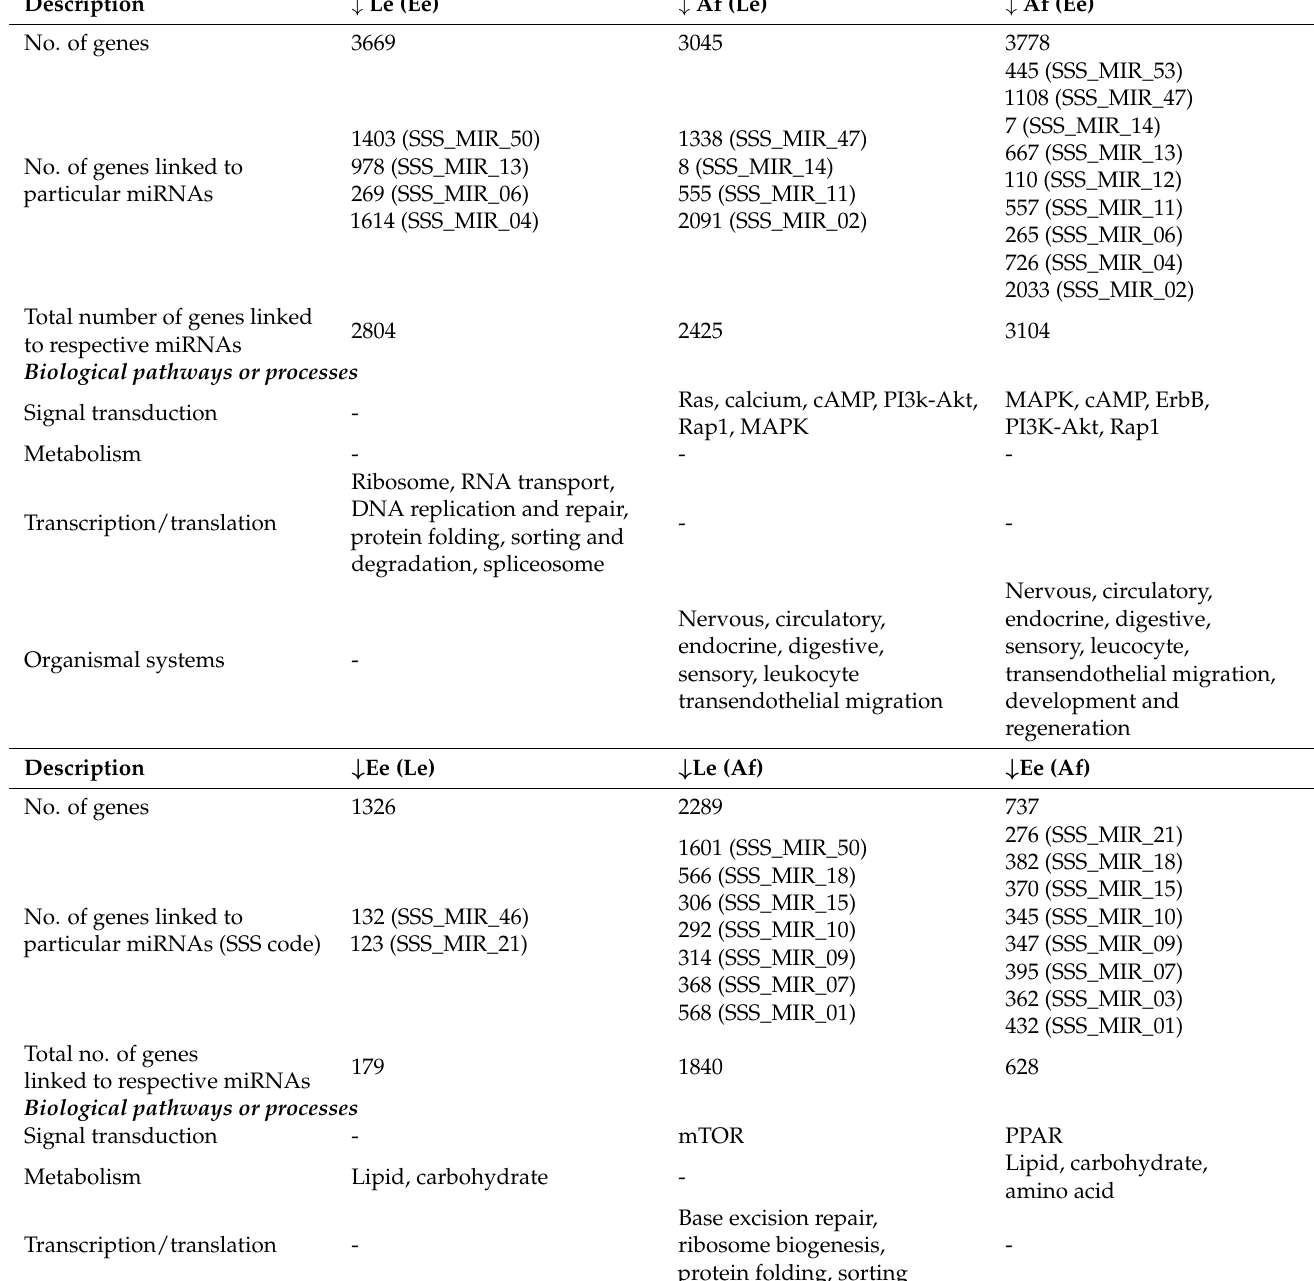
Table 1. MicroRNAs (SSS_MIR codes; cf. Table S2) linked to genes whose transcription (mRNA) was significantly decreased ( ↓ ) in a particular developmental stage (relative to another stage) of Sarcoptes scabiei (cf. colour codes in Figure 1). Stages: Ee—early egg, Le—late egg (Le) and Af—adult female. Enriched biological pathways or processes that were inferred to be linked to reduced transcription are